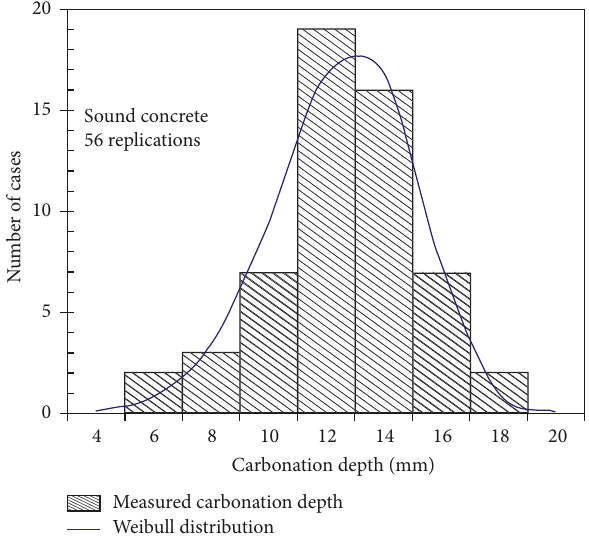
Figure 4: Distribution of carbonation depth values obtained from field data for sound concrete.